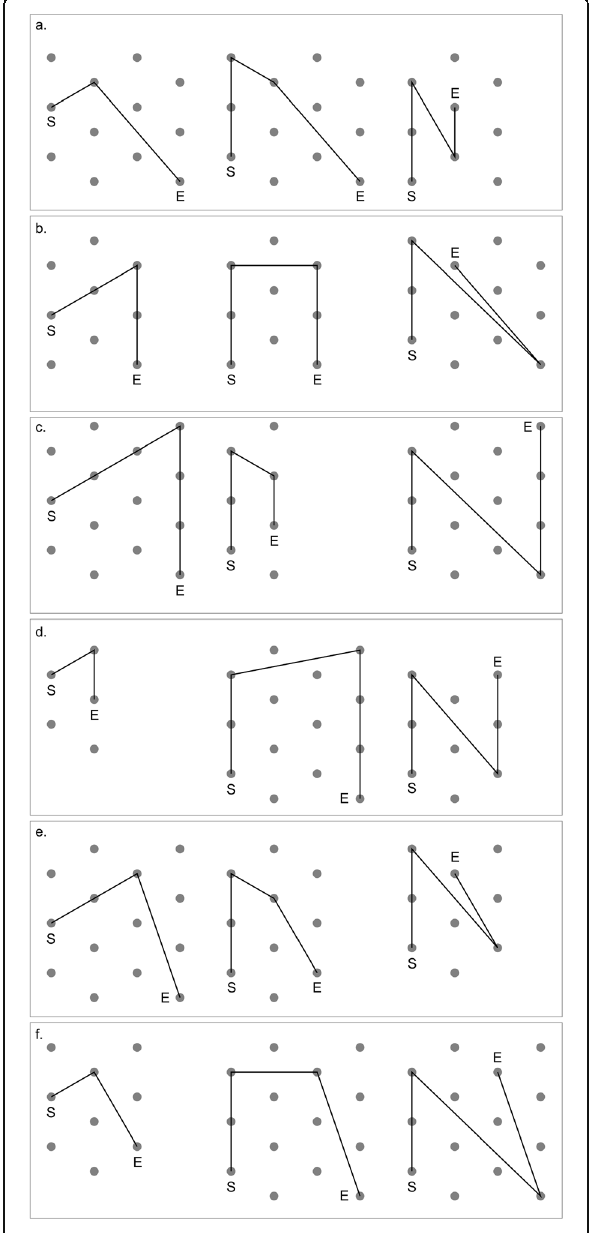
Fig. 2 Paths for the training tasks. Participants in the training condition practiced allocentric spatial updating on three paths in each session (paths a – f assigned to sessions 1 – 6). Triangle paths are shown in the left column, quadrilateral paths in the middle column, and crossing paths in the right column. Participants walked the paths from the start to the end, blindfolded and guided by the experimenter, and were asked to go directly back to the starting point by themselves, still blindfolded. When they indicated that they reached the starting point, they were asked to point in the direction of north. The gray dots, used for scaling, are placed 1.5 m apart. S = start; E =